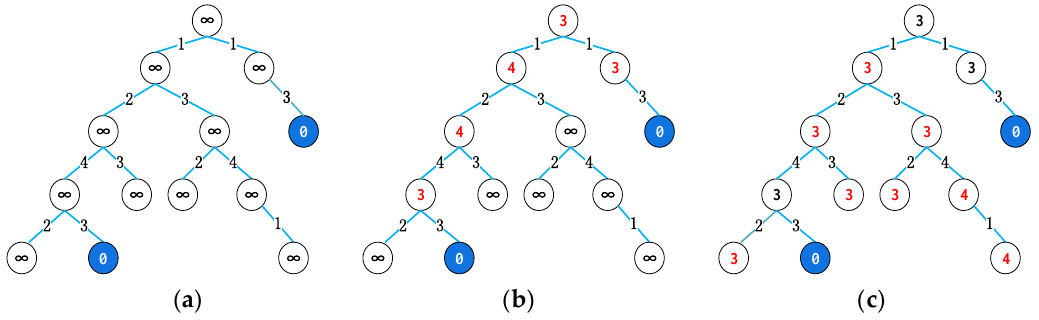
Figure 4. An illustration of the two-stage minimum bottleneck distance transform. In ( a ), only the distance values of the seed nodes are set to 0. ( b ) demonstrates the bottom–up updating process from the leaves, and the changed values are labeled in yellow color. ( c ) shows the top–down traversal process from the root node.